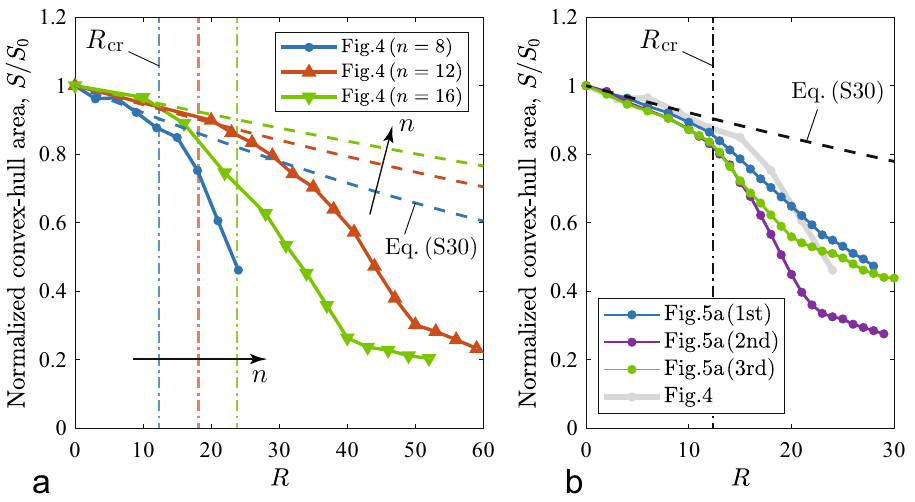
Figure 6. Comparison of S / S 0 vs. R predictions (dash) obtained from Eq. (S30) with measurements (solid) shown in ( a ) Fig. 4 and ( b ) Fig. 5. In the pre-conformational model, the assumption is that an initial loop with n + 1 segments, including the attachment space, is contracted uniformly in 2D. A common correction factor of (cid:31) ≈ 0.1315 is used; see Sec. S6.3 for details. The vertical lines indicate the critical points of R Eq.